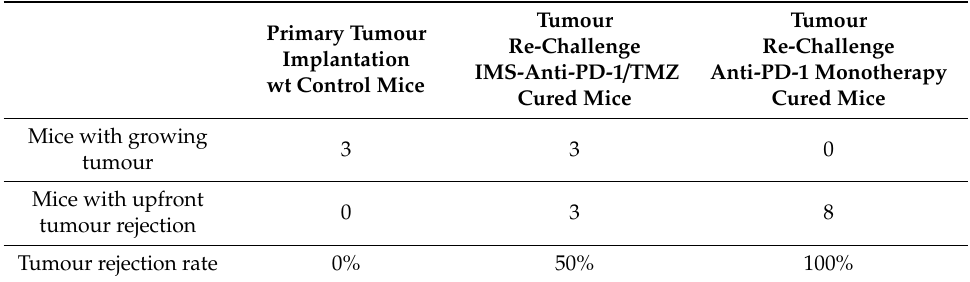
Table 2. Comparison of the GL261 tumour take rates between primary tumour implantation,